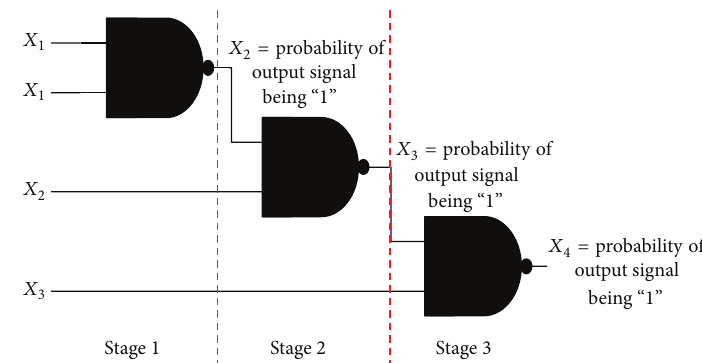
Figure 8: Series of NAND gates for computing its exact error